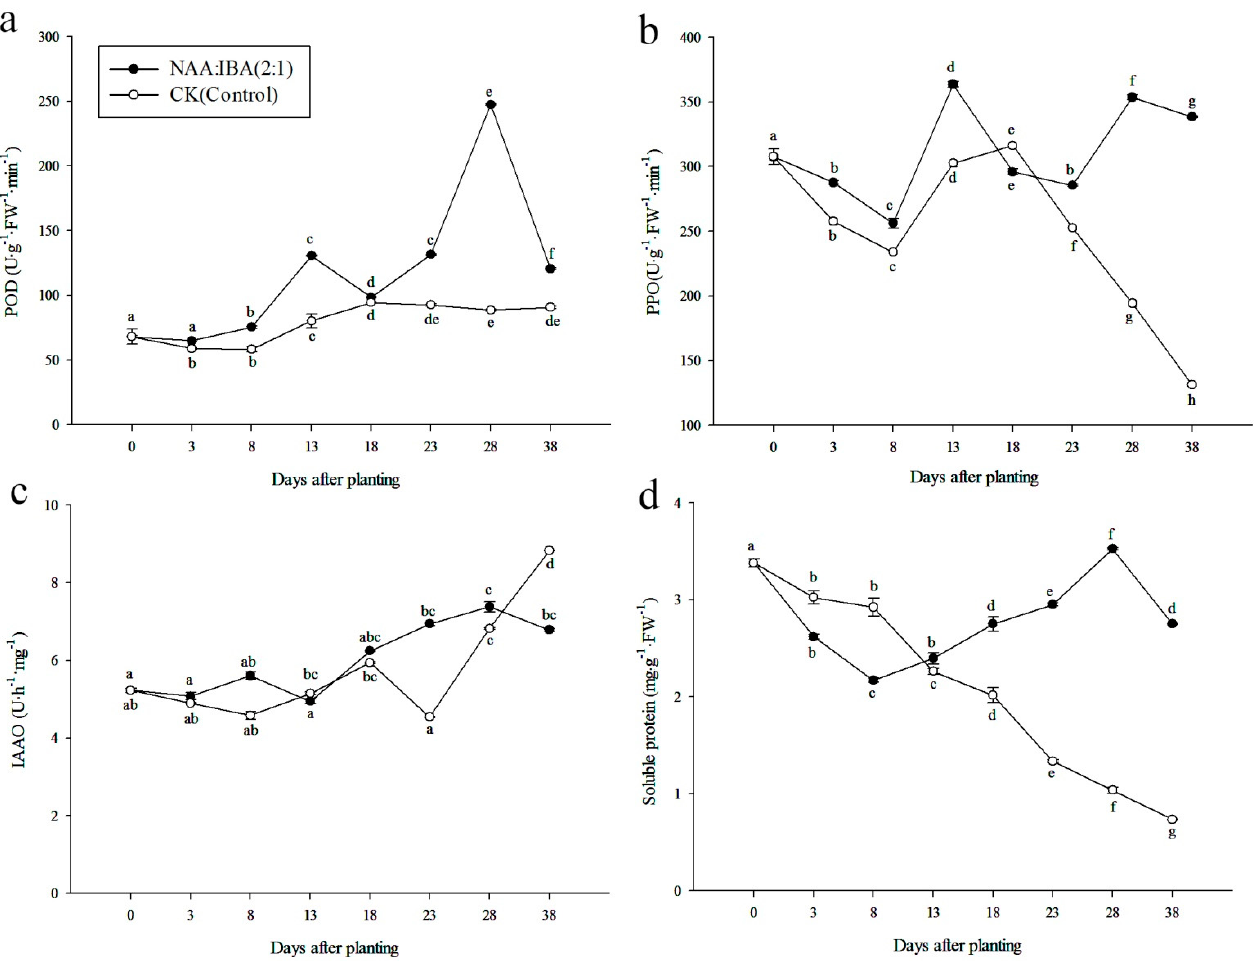
Figure 9. Changes in the enzymatic activities and soluble protein contents during rooting in stem cuttings of M. wufengensis. ( a ) POD activities. ( b ) PPO activities. ( c ) IAAO activities. ( d ) Soluble protein contents. Data are the means of three replicates ± SE, for 20 cuttings per treatment. Letters on the top of each point show p < 0.05, same letters show the non-significant difference while different letters show a significant difference between different days after planting.